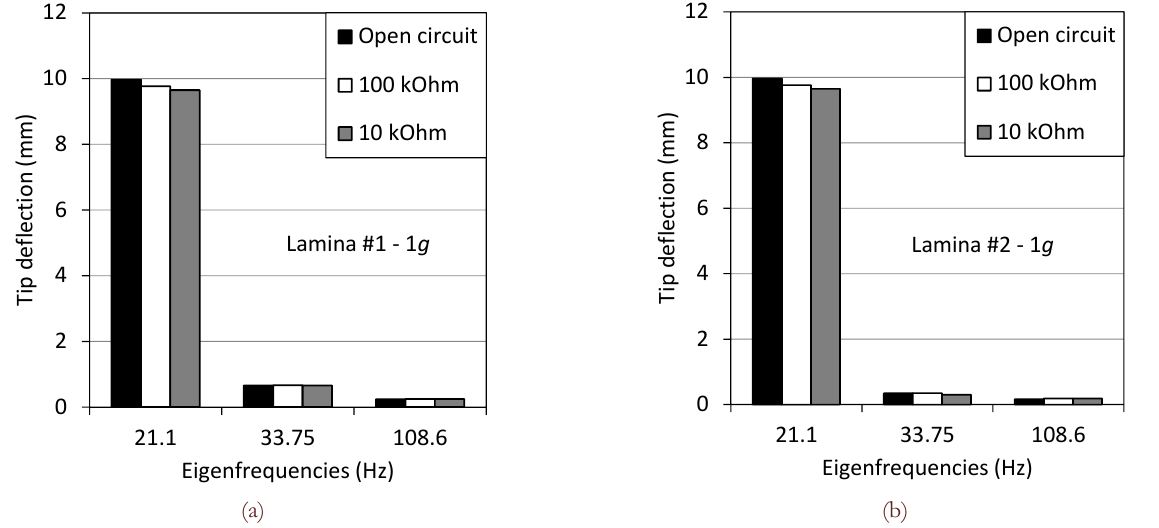
Figure 6: Bar charts of the tip displacement measured experimentally for each eigenfrequency to an acceleration of 1 g: lamina #1 (a), and lamina #2